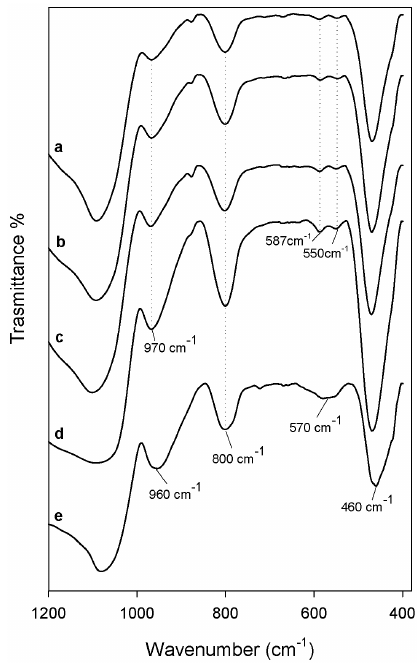
Figure 5. Representative FTIR spectra of ( a ) SiO 2 /PEG 6 wt % /CGA 20 wt % ; ( b ) SiO 2 /PEG 12 wt % /CGA 20 wt % ; ( c ) SiO 2 /PEG 24 wt % /CGA 20 wt % ; ( d ) SiO 2 /PEG 50 wt % /CGA 20 wt % after 21 days of exposure to SBF; and ( e ) SiO 2 /PEG 12 wt % /CGA 20 wt % before soaking in SBF.